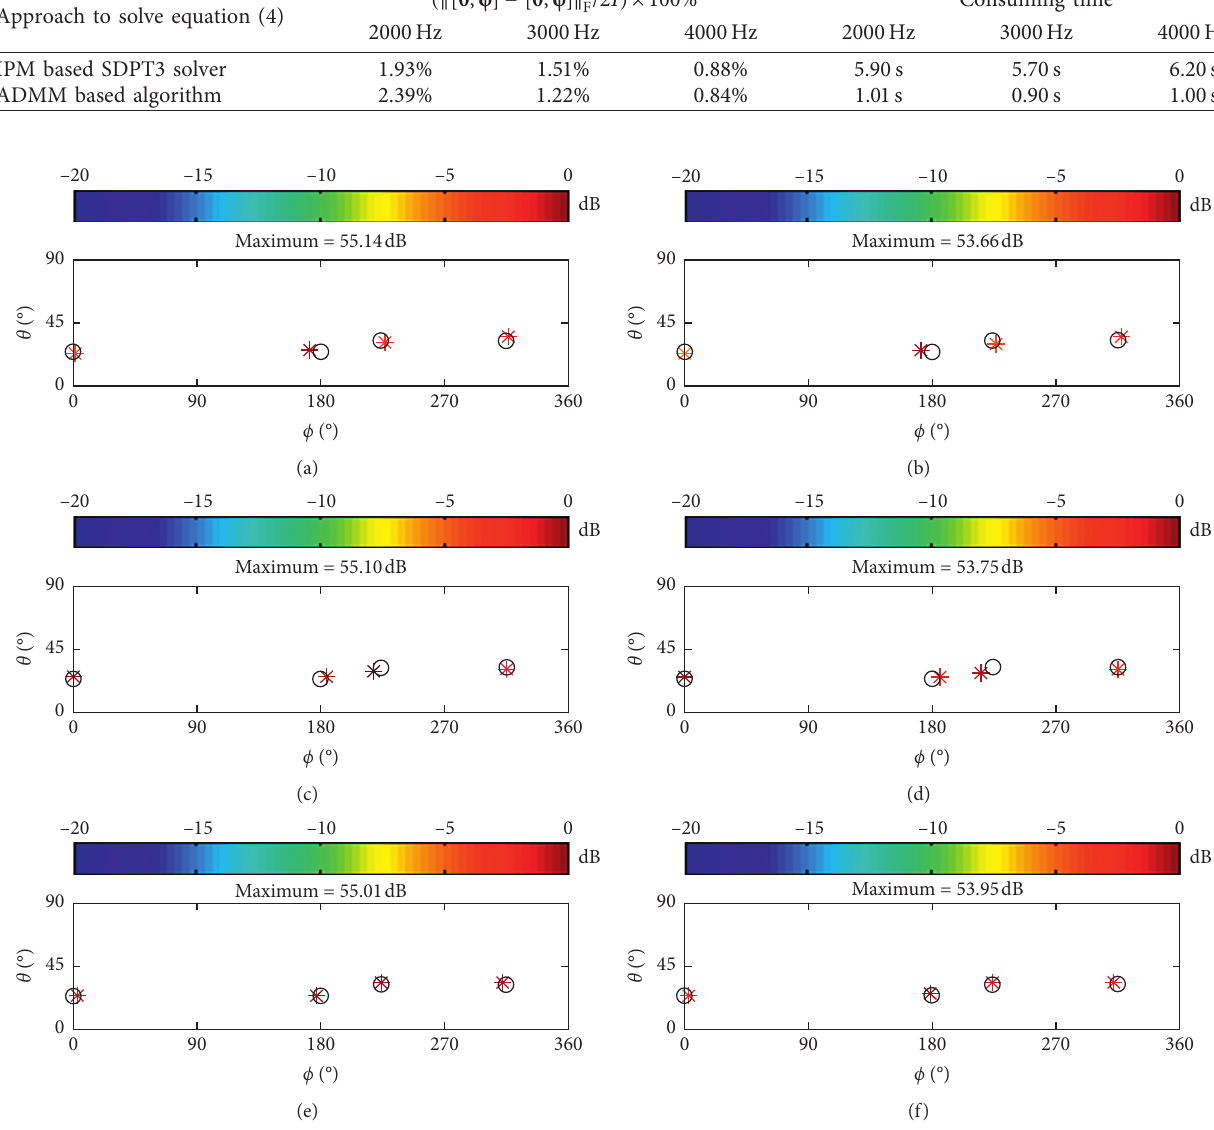
Figure 6: Loudspeaker source maps at (a), (b) 2000Hz, (c), (d) 3000Hz and (e), (f) 4000Hz obtained by the two-dimensional multiple- snapshot grid-free compressive beamforming using (a), (c), (e) the IPM based SDPT3 solver and (b), (d), (f) our ADMM based algorithm. The non-uniform array with 30 microphones is employed. Table 2: DOA estimation error corresponding to Figure 6 and consuming time of IPM based SDPT3 solver and ADMM based algorithm. Approach to solve equation (4)